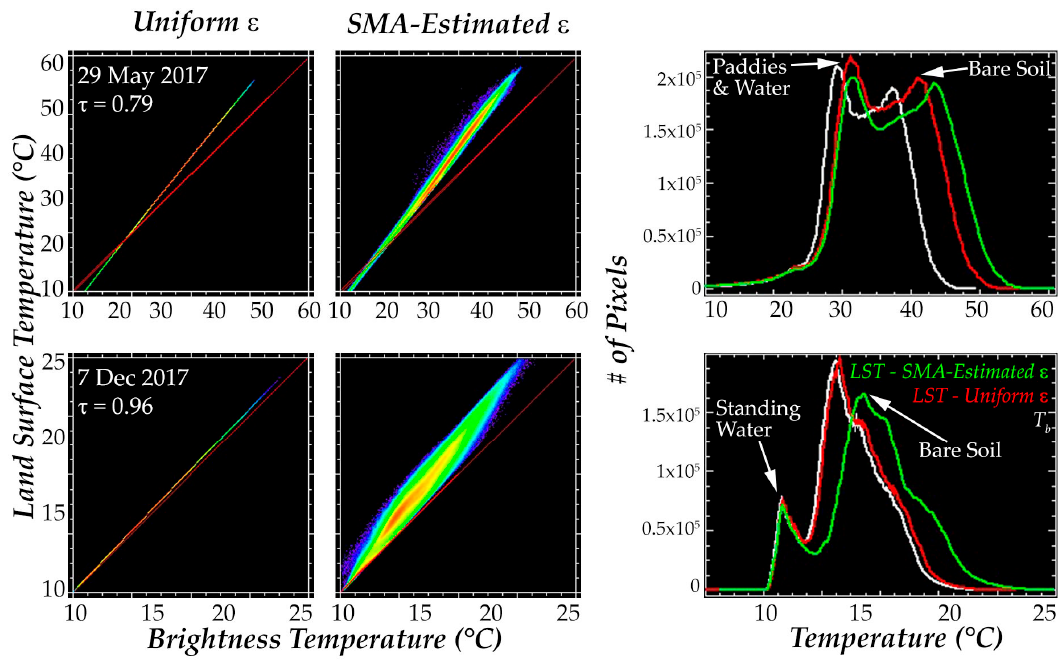
Figure 2. Effect of atmospheric correction and emissivity estimation on temperature estimates. In the case of a relatively low τ atmosphere and high insolation (top row, τ = 0.79), atmospheric correction increases T of rice paddies by about 2 °C and bare field about 4 °C. In the case of a high τ atmosphere with low insolation (bottom row, τ = 0.96), atmospheric correction changes T estimates by less than 0.5 °C. Using pixelwise ε estimates in the May image results in an additional 0.5 °C increase for paddies and a 2 to 3 °C increase for bare soil. In the December image, pixelwise ε results in no change in standing water but a 2 to 2.5 °C increase for bare soil.